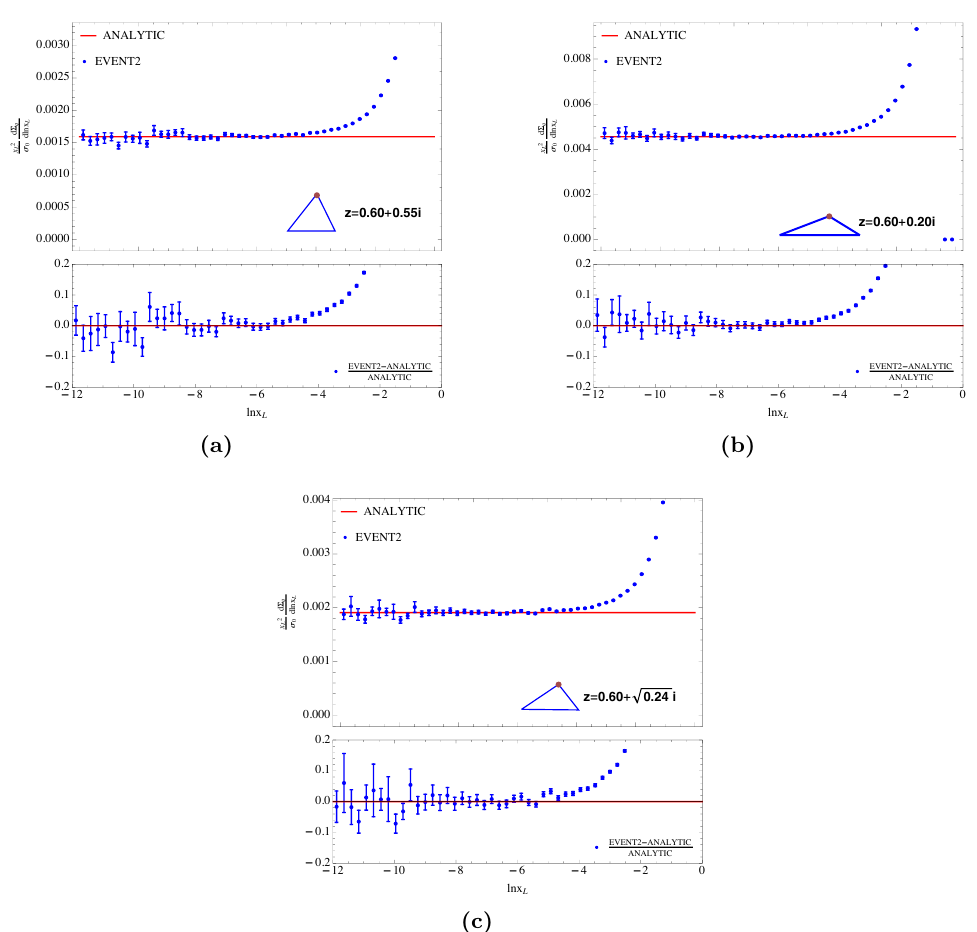
Figure 12. Comparison between Event2 in the asymptotic regime and our analytic results for di(cid:11)erent shapes of the triangle span by the three indicated points: (a) acute triangle; (b) obtuse triangle; (c) right